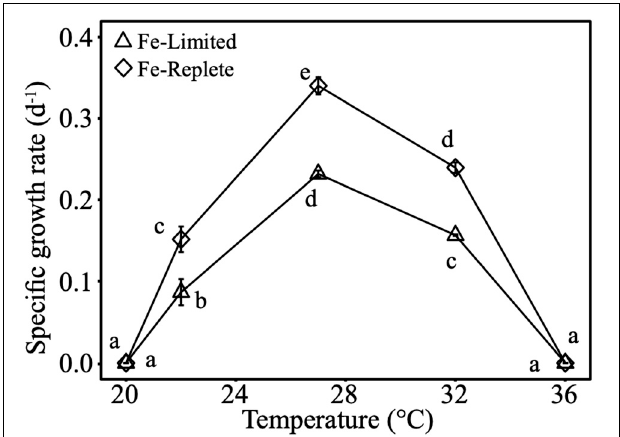
FIGURE 1 | Cell-specific growth rates of Crocosphaera grown under Fe-replete and Fe-limited conditions across 5 temperatures (20, 22, 27, 32, and 36 ◦ C) that span their thermal range. Error bars are standard deviations of the means of triplicates, and different letters represent statistical significance between growth rate means at p- value <